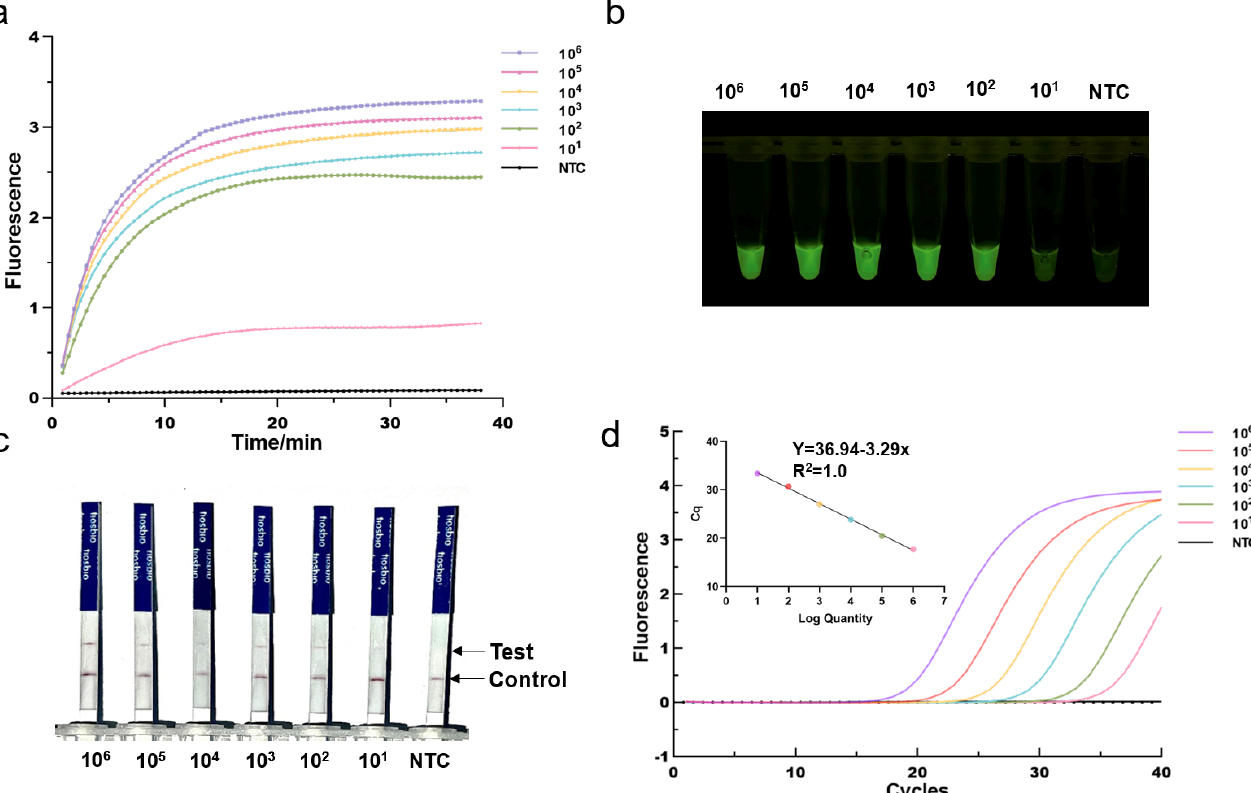
Figure 4. Determination of the sensitivity of RPA-CRISPR/Cas12a assays. Different concentrations of MRSA Plasmids (10 1 to 10 6 copies per reaction) were used test. ( a ) Real-time fluorescence RPA- CRISPR/Cas12a detection of different MRSA dilution. NTC: no template control. ( b ) Endpoint fluorescence/visual detection to MRSA plasmid dilution. ( c ) LFS-based RPA-CRISPR/Cas12a de- tection assay of MRSA plasmid dilution. Except for the blurred sample 10 copies/reaction test lines, all samples had clear test lines. ( d ) qPCR amplification curves and standard curves for MRSA plasmid